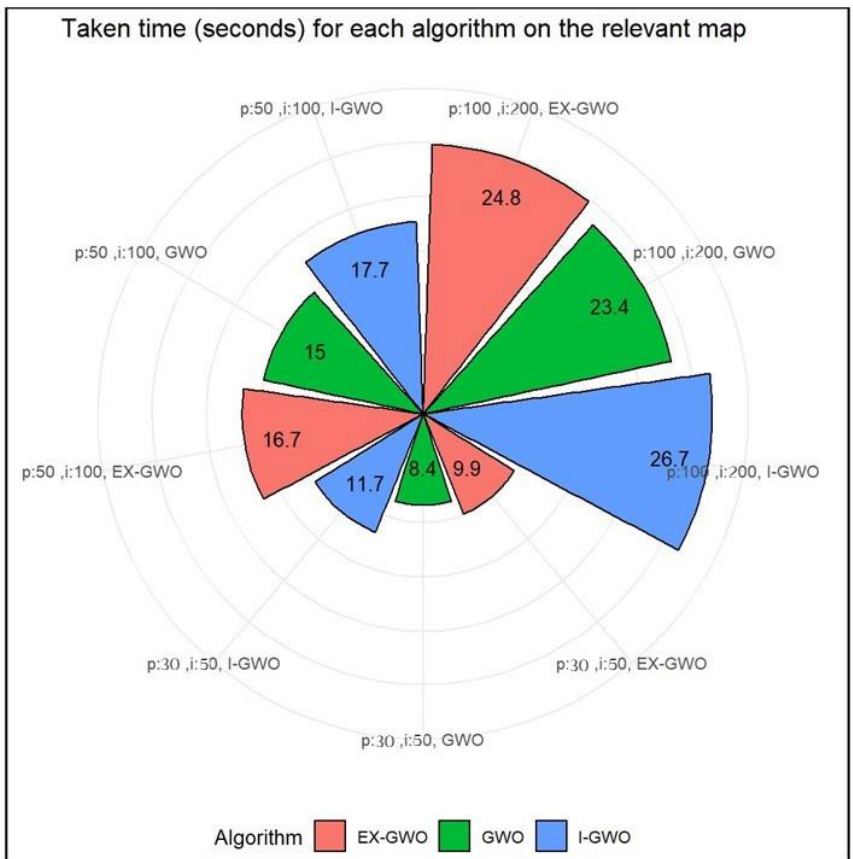
Figure 8. Taken time for each method on the relevant map.